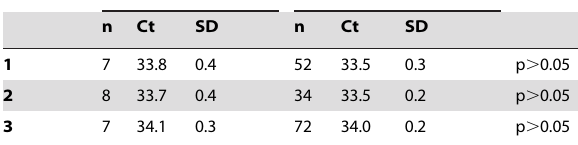
Table 2. Comparison of the mean Ct value of the internal amplification control in no-template controls and blood cultures tested negative for Leptospira sp.